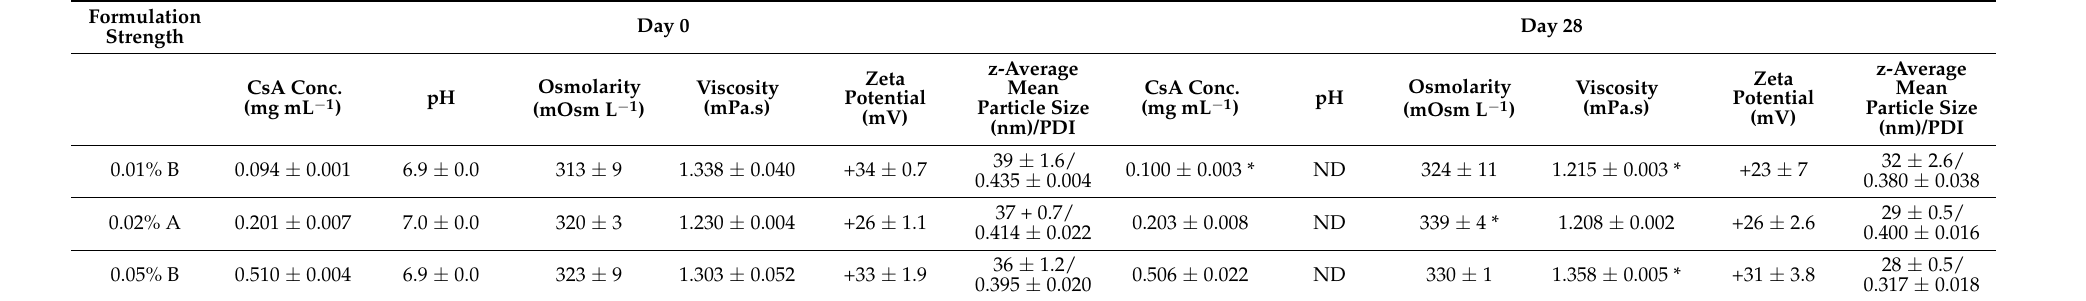
Table 4. NM133 Storage at Room Temperature (18–23 ◦ C), mean ± s.d. from three independent